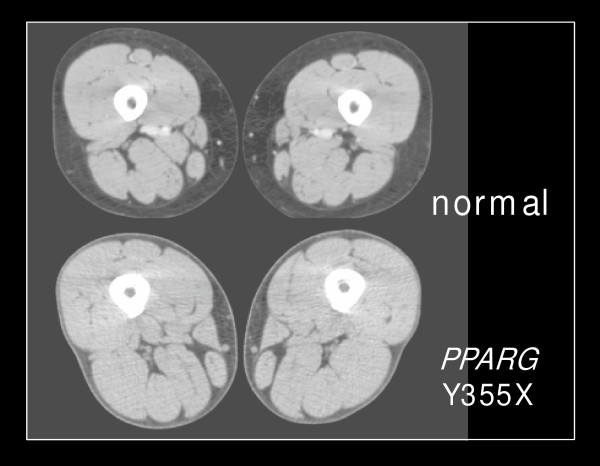
Selected imaging studies from the FPLD3 subject. Panel shows computed tomography cross-section of upper thigh of a normal individual and subject II-5, who had markedly decreased subcutaneous fat on both extremities.